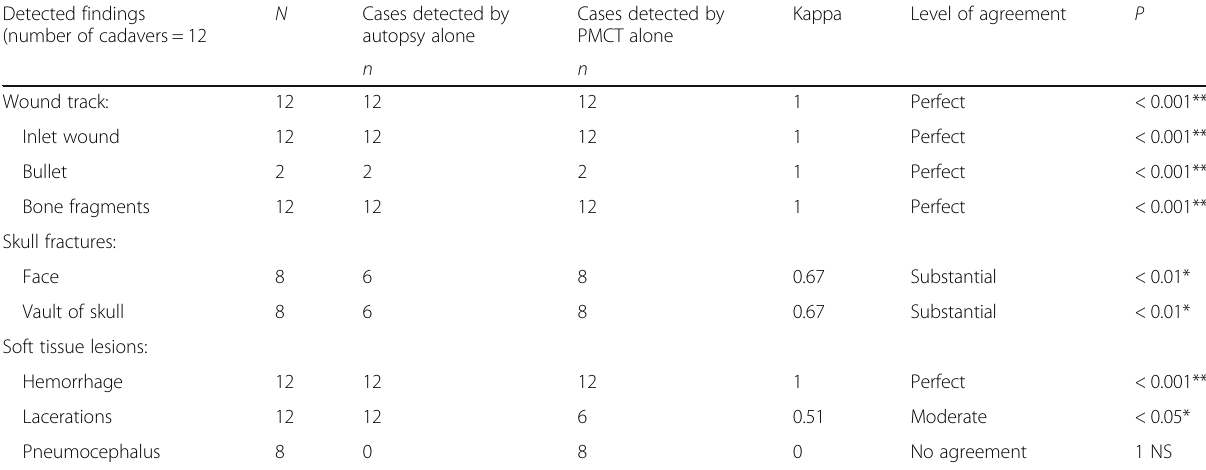
Table 1 Degree of agreement between PMCT and autopsy in detection of injuries in cases of firearm injury in the head by Cohen ’ s Kappa